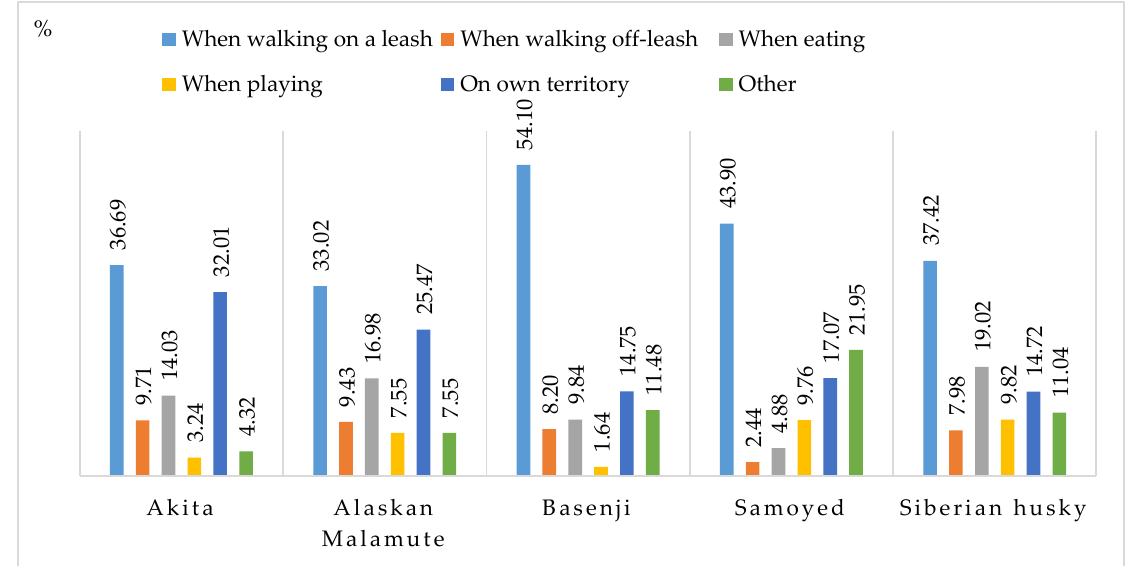
Figure 4. Situations that elicit an aggressive response towards other dogs/animals (%).